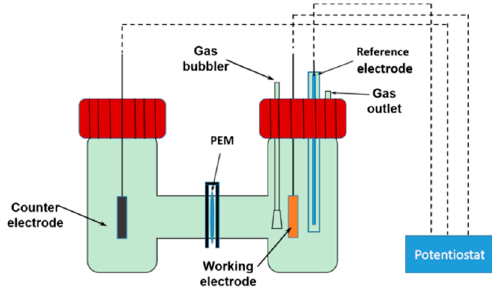
Figure 1. A schematic drawing of H-type cell.